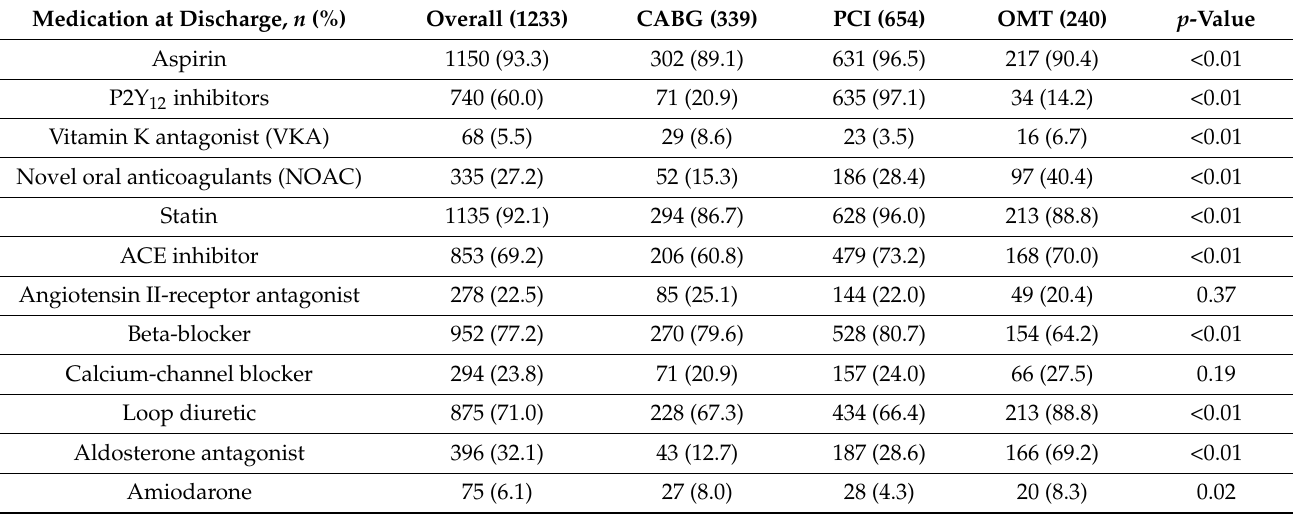
Table 2. Cardiac-related medications given at discharge.